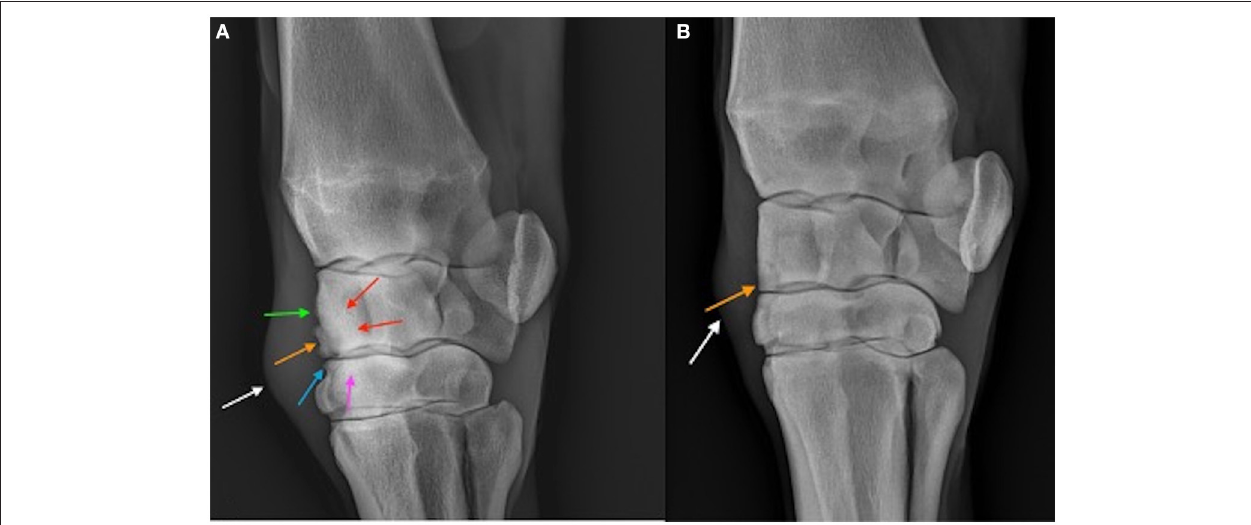
FIGURE 6 | Dorsolatero-palmaromedial oblique radiographs of a placebo treated horse (A) and BO treated horse (B) on Day 70. The osteochondral fragment is visible in both horses (orange arrow). Sclerosis of the third carpal bone (pink arrow) and radiocarpal bone (red arrows) are visible in the placebo treated horse as well as enthesopathy of the joint capsule (green arrow), and osteophytosis (blue arrow). Soft tissue swelling (white arrow) representing middle carpal joint effusion is the only common abnormality between the two horses.